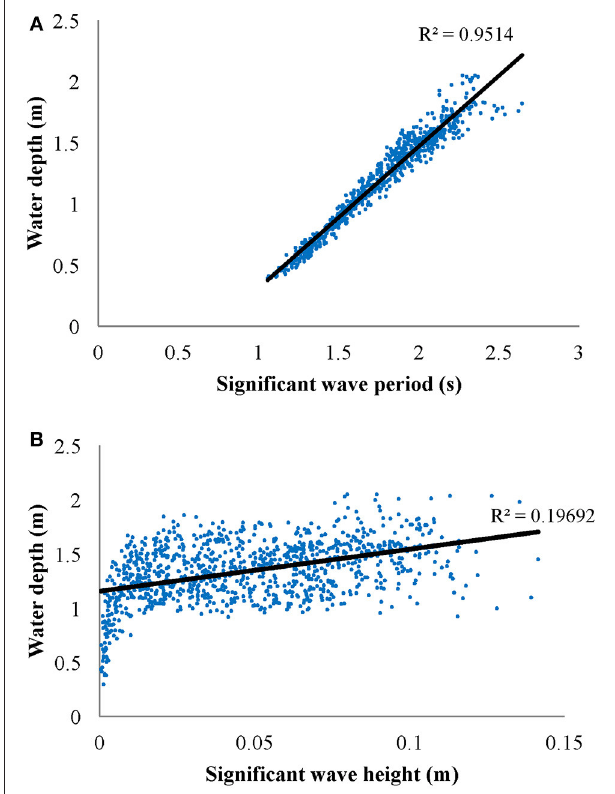
FIGURE 7 | (A) Significant wave period (s) vs. water depth (m) for waves with significant wave height > 5cm and (B) significant wave height (m) vs. water depth (m) for significant wave period < 5s. Data is from October 2012 recorded at the Center site.